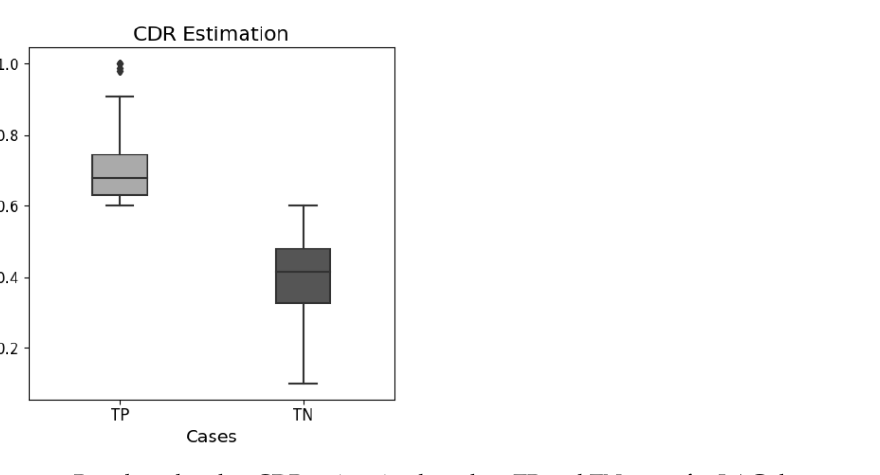
Figure 10. Boxplot related to CDR estimation based on TP and TN cases for LAG dataset.